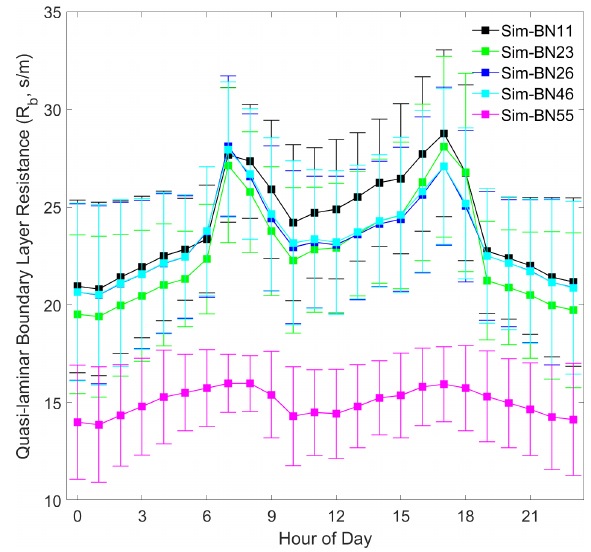
Figure 6. Diurnal variation of simulated R b .